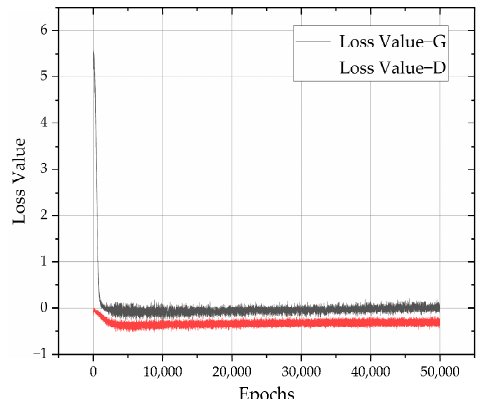
Figure 9. Variation of loss values of generators and discriminators.